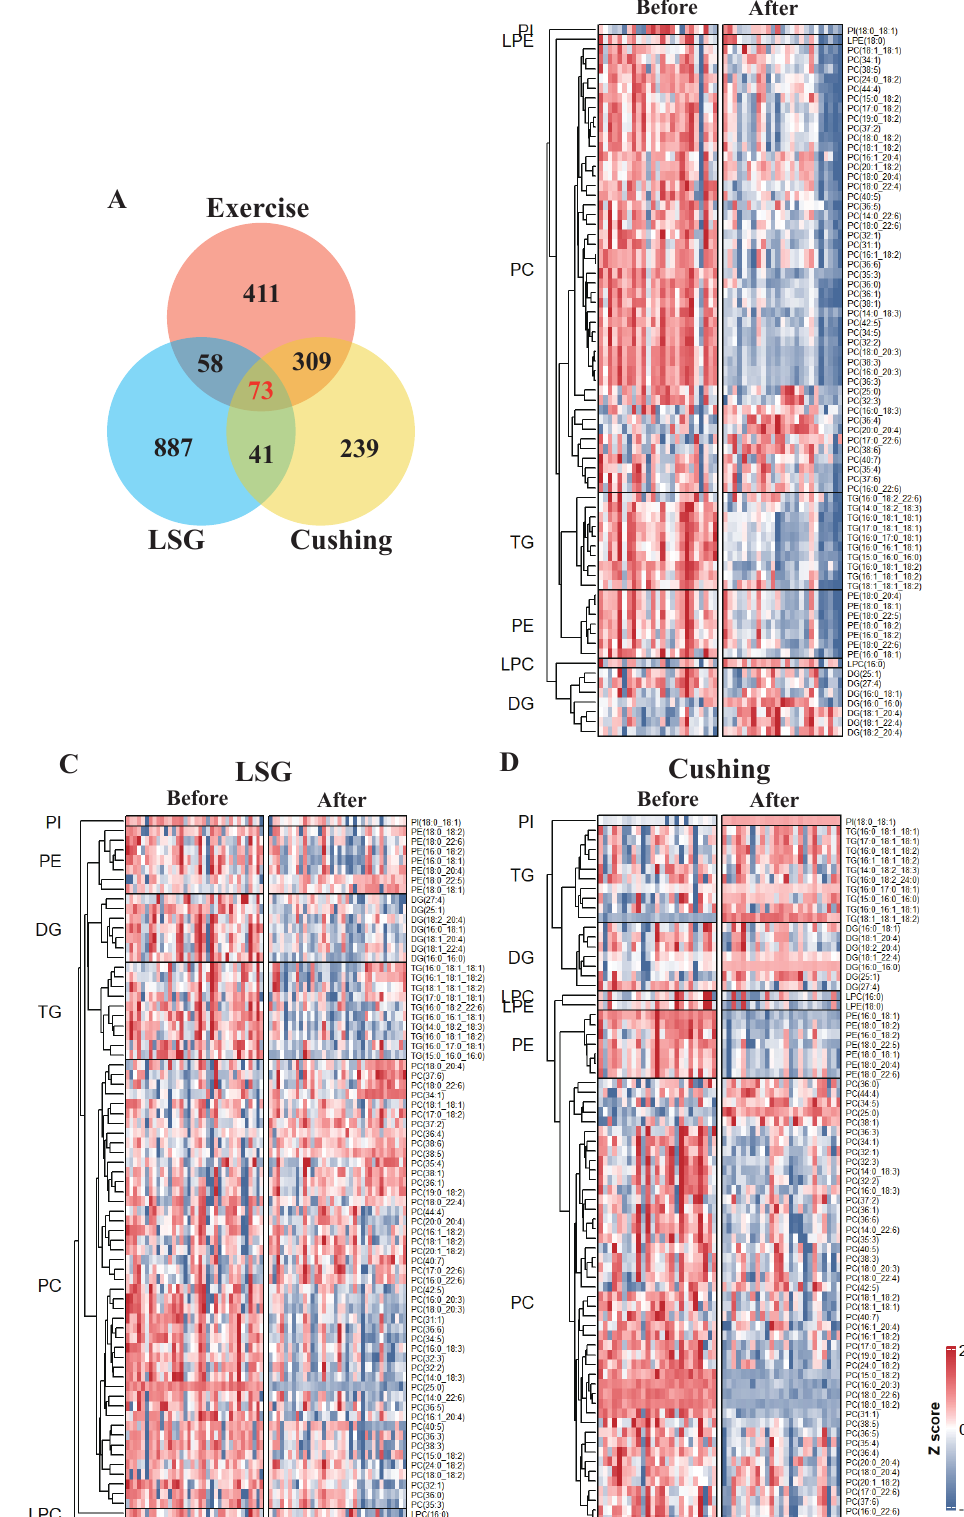
Figure 5. Changes in common lipid species of Exercise, LSG, and Cushing. ( A ) Venn plot shows overlap lipid species among Exercise (pink), LSG (blue), and Cushing (yellow), the Wilcoxon Signed Rank Test ( q value < 0.1), 73 common lipid species can be found in the three studies. ( B – D ) Heatmap of the relative concentrations of 73 lipid species in Exercise ( B ), LSG ( C ), and Cushing ( D